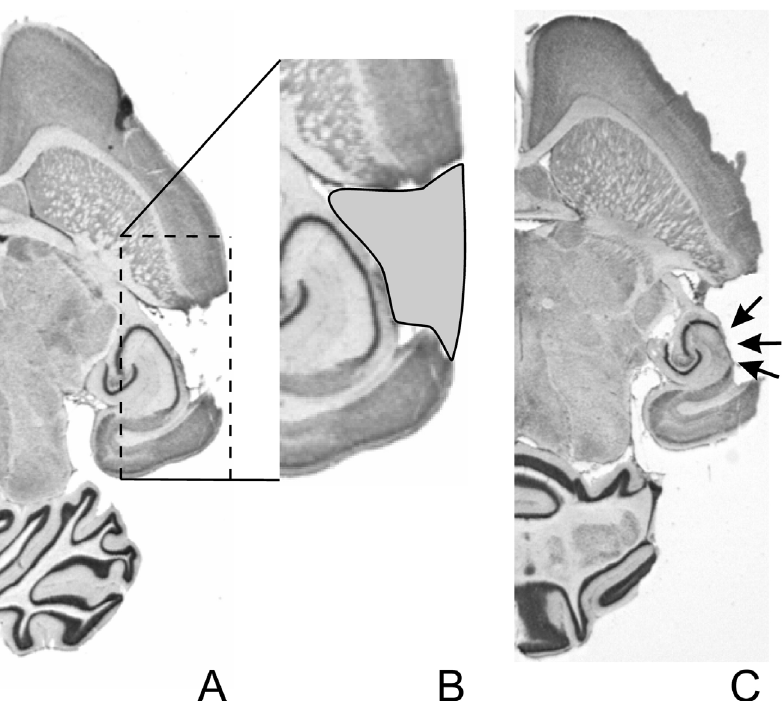
Figure 1. Histological verification of lesion size and location. Shown are two examples (A and C) of Nissl-stained horizontal brain sections. A For animals in which no damage to the hippocampus could be detected. B The contour of the lesion was determined manually for later computation of lesion volume (cf. Methods). C Animals that showed damage to the hippocampus (the arrows point to damage of parts of the alveus, stratum oriens and stratum pyramidale of the hippocampus) were excluded from further analysis. (top panels, blue curves): Nonlinear regression analysis between CR + -curves of left or right lesioned groups vs. the control group showed no significant differences in LS across the first 7 training days (Left vs. control: Beta = 0.02, t(414)= 0.66, p= 0.50; Right vs. control: Beta = 0.01, t(383)= 0.31, p =0.75). In addition, Mann- Whitney U-tests across the first seven days detected no significant differences (given is the median (lower quartile, upper quartile): Left (18 (11, 24)) vs. control (16 (9, 22)), p= 0.13; Right (19(11, 23)) vs. control (16 (8, 24)), p= 0.10). The same was true when functions for final discrimination performance over the last 8 days (DP, not shown in figure) where analysed: Again, no significant differences were seen between lesioned and control groups.